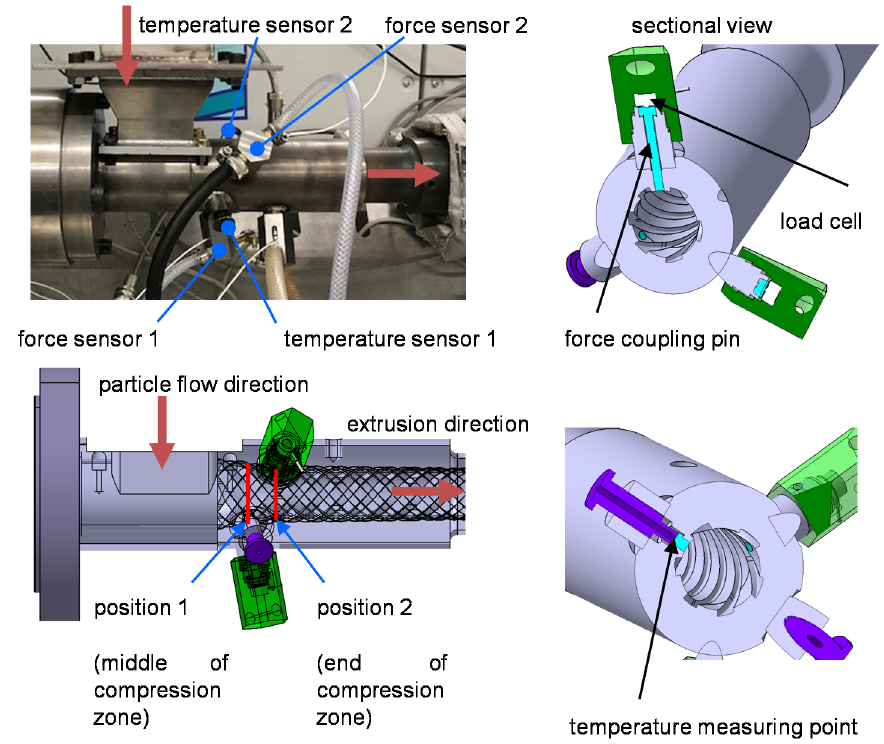
Figure 11. Radial force and temperature measurements at the feed zone.